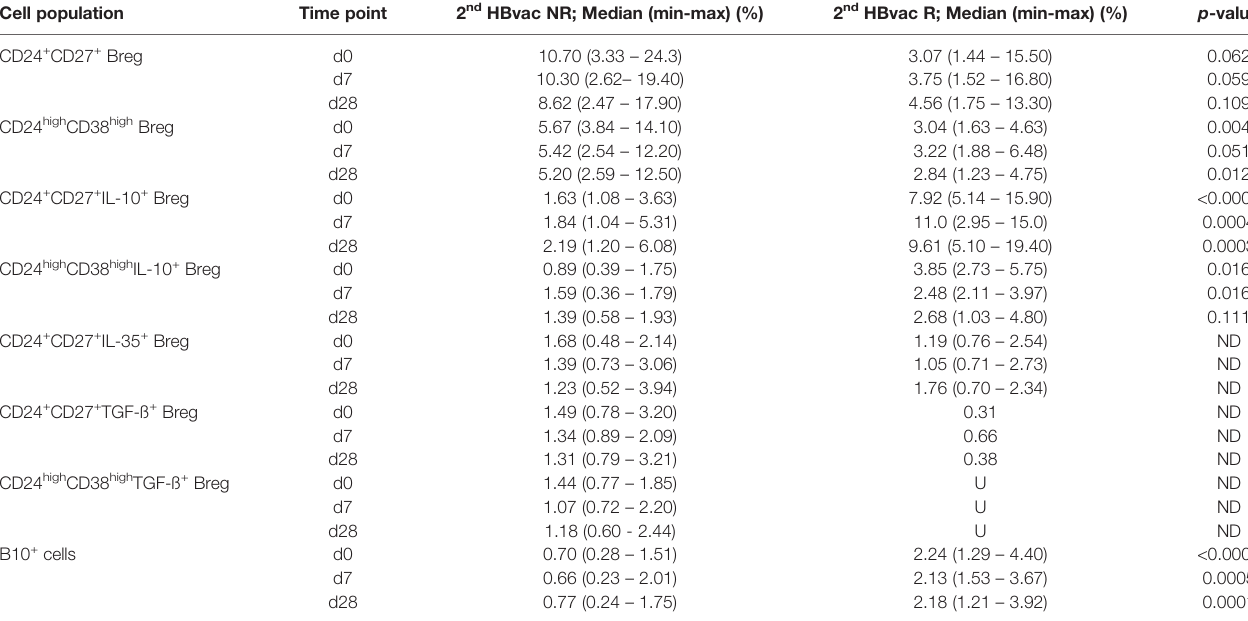
TABLE 2 | Frequencies and cytokine expression levels of CD24 + CD27 + and CD24 high CD38 high Breg and B10 + cells. Cell population Time point